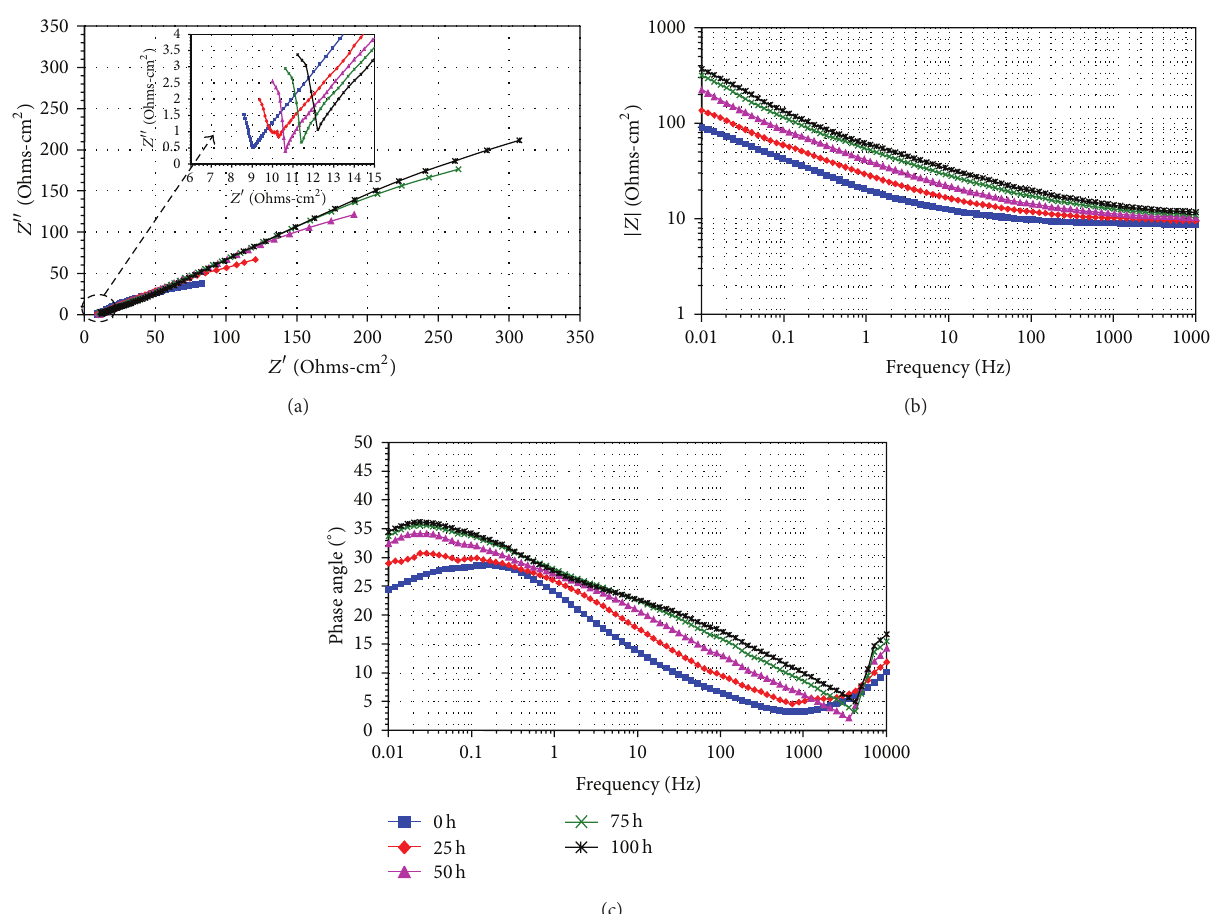
Figure 3: Evolution of the Nyquist and Bode plots of the EIS response of the Ni in NaVO 3 at 700 ∘